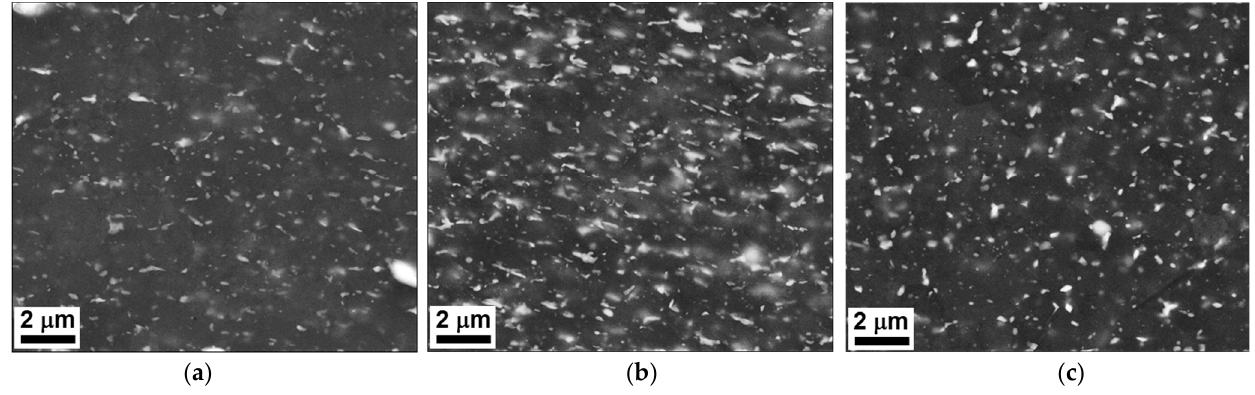
Table 2. Variation of volume fraction of secondary precipitates within stir zone (in vol.%).